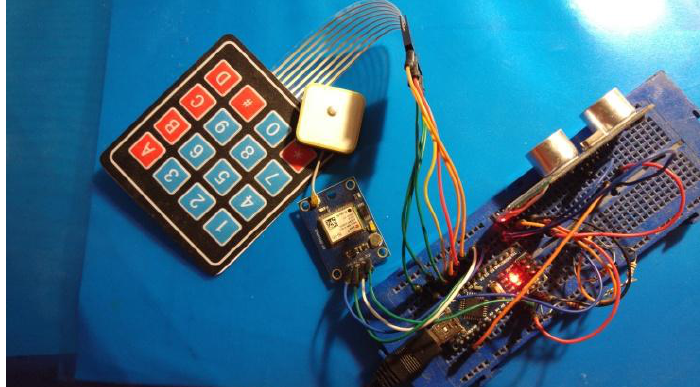
Figure 2. Blind RouteVision prototype embedded system hardware. The device components are clearly shown (left to right): hex-keypad, high-precision GPS receiver with white square antenna, and breadboard with directly plugged in Atmega uC tiny daughter board, Bluetooth transceiver (touching the sonar left side) and sonar (top to bottom view, illustrated also in Figure 1a).